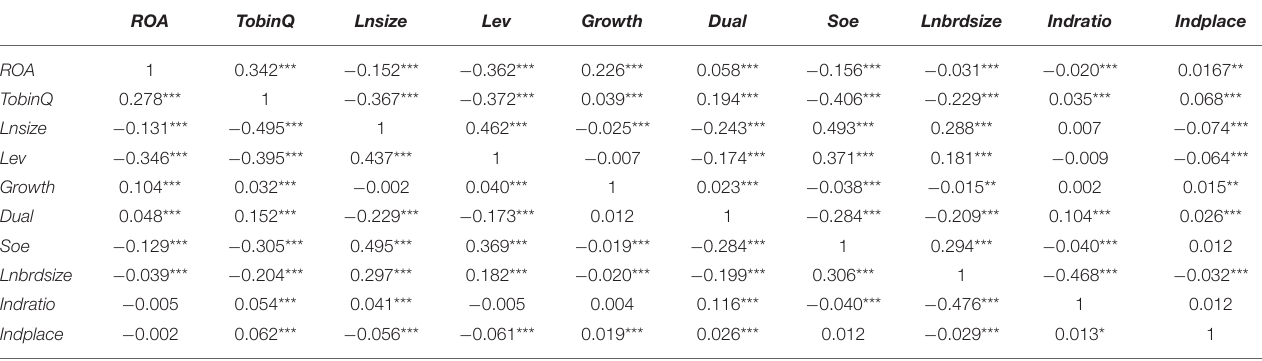
TABLE 5 | Correlation matrix of the main variables. ROA